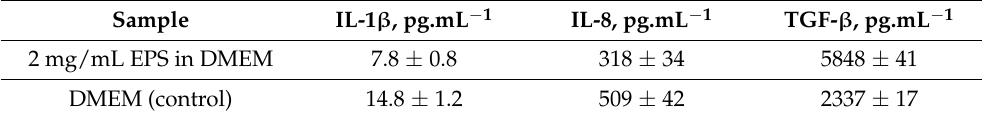
Table 7. The anti-inflammatory activity of crude exopolysaccharide (EPS) by T. versicolor NBIMCC 8939.